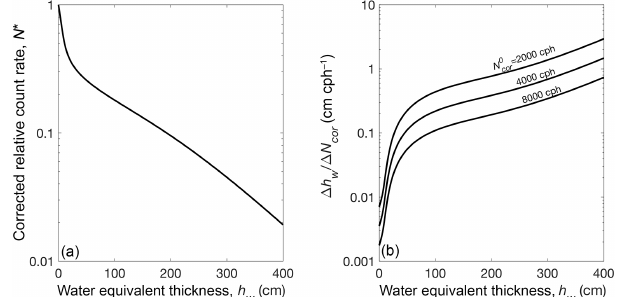
Figure 2. (a) Relationship between water-equivalent thickness, h w , and the relative hourly corrected count rate, N ∗ , measured by the cosmic ray neutron sensor (CRNS), as obtained from Eqs. (4) and (5) and the parameters provided in Table 1. (b) The change in h w per change in hourly corrected count rate, N cor , for count rates at h w = 0 (i.e. the corrected count rate when no snow is covering the sensor, or N 0 cor ) of 2000, 4000 and 8000 counts per hour